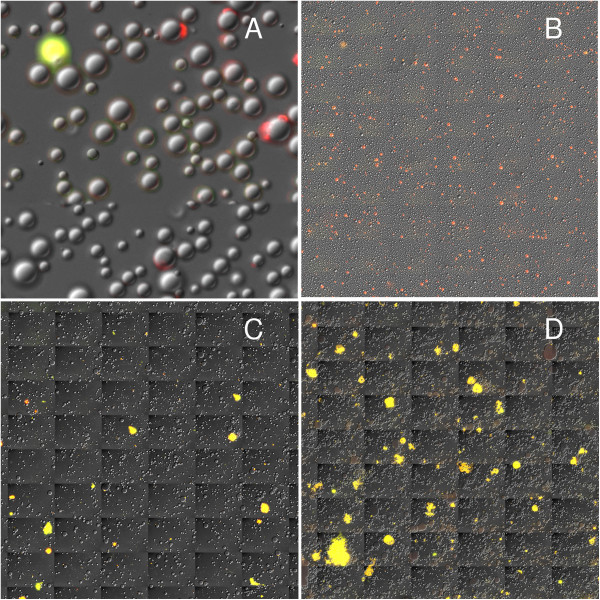
Composite images of whole milk stained with acridine orange (AO). Each image contains three channels: 1) a differential interference contrast image to view the fat globules, which look like gray bubbles; 2) a fluorescence channel for AO-RNA; and 3) another fluorescence channel for AO-DNA. When AO associates with RNA, the emission maximum is 650 nm (red). When AO associates with DNA, the emission maximum is 525 nm (green). Therefore, areas containing only RNA (e.g. crescents) look red, only DNA look green, and both RNA and DNA (e.g. nucleated cells) look yellow. (A) Close-up of human whole milk with a nucleated cell (yellow) and several crescents of various sizes. (B) Whole slide scanned image of human whole milk collected after a 4-hr milk accumulation. (C–D) Whole slide scanned images of macaque whole milk after (C) a 4-hr and (D) a 10-min milk accumulation.